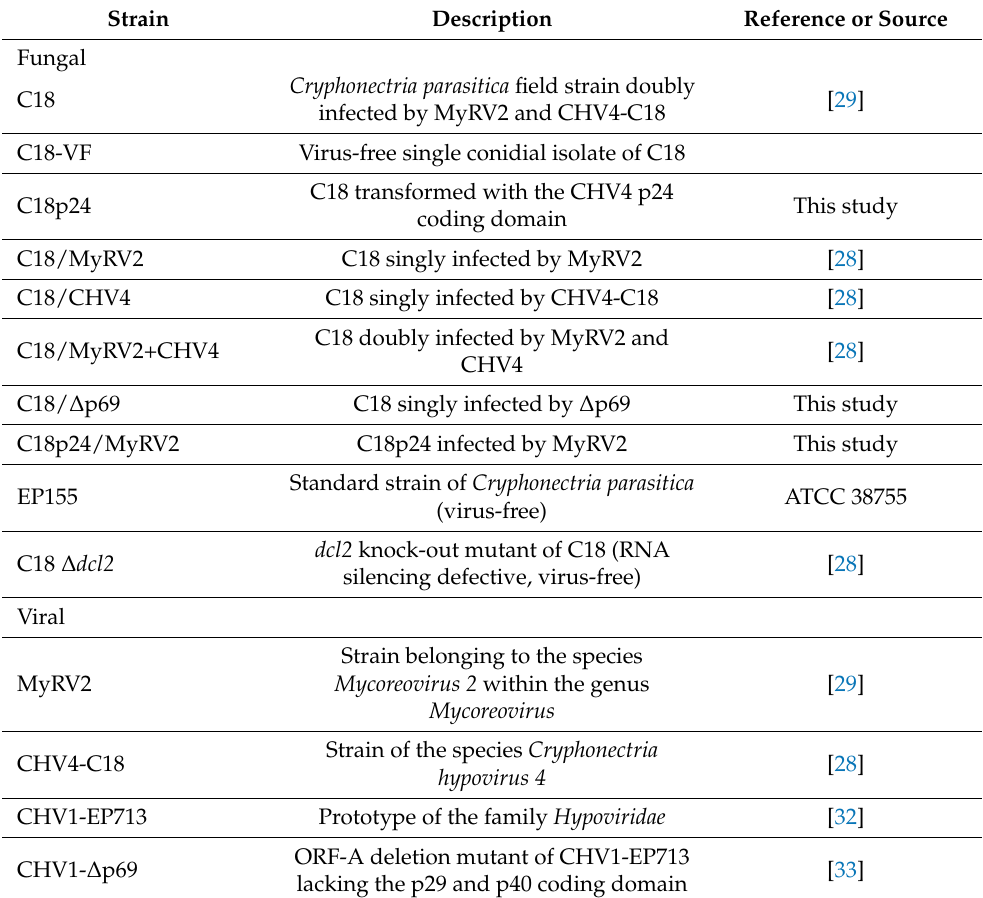
Table 1. Fungal and viral strains used in this